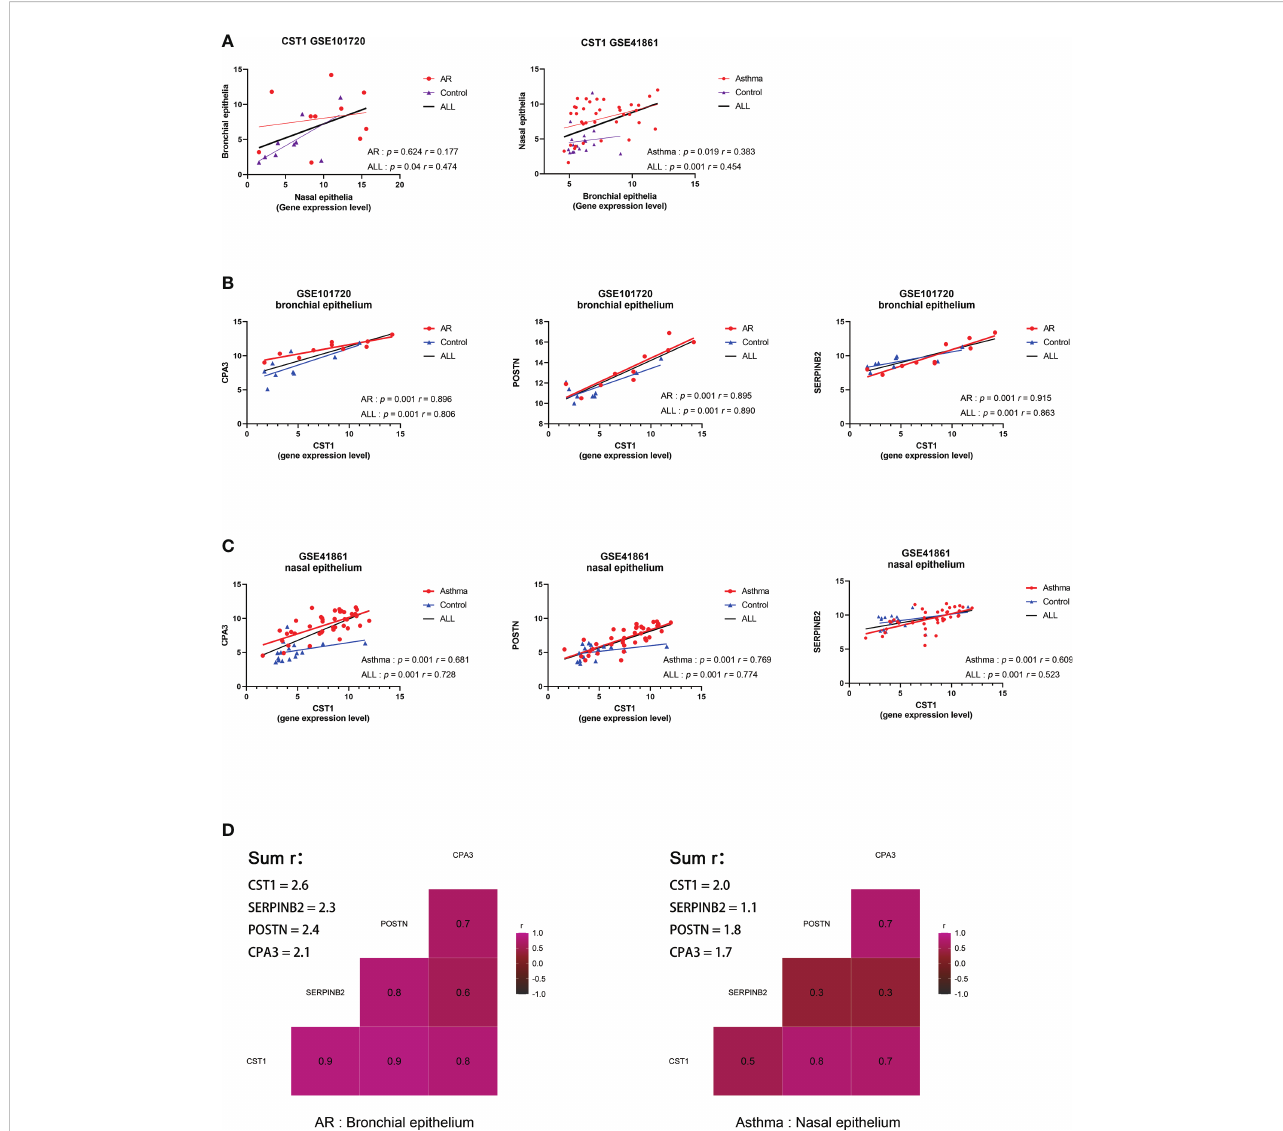
FIGURE 4 Correlation analysis of key genes. (A) Correlation analysis and scatterplot of CST1 expression levels in nasal and bronchial epithelium in GSE101720 and GSE41861. (B) Correlation analysis and scatter plot of the expression levels of CST1 and key genes CPA3, POSTN, and SERPINB2 in the bronchial epithelium of AR patients. (C) Correlation analysis and scatter plot of the expression levels of CST1 and key genes CPA3, POSTN, and SERPINB2 in the nasal epithelium of asthma patients. (D) Heatmap of the correlation between CST1 and key genes CPA3, POSTN, and SERPINB2 in the bronchial epithelium of AR patients and nasal epithelium of asthma patients. AR, Allergic